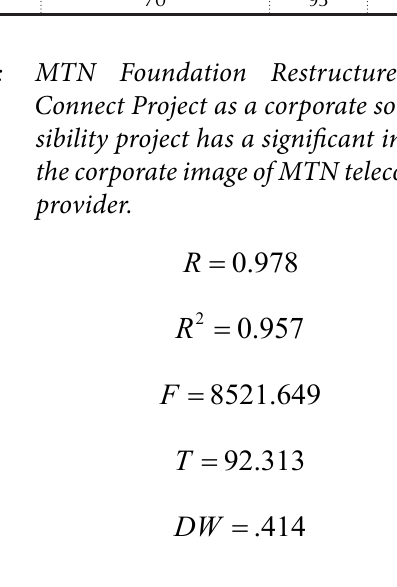
Table 4 indicates that the regression sum of squares (456.873) is greater than the residual sum of squares (20.373), which indicates that more of the variation in the dependent variable is not explained by the model.